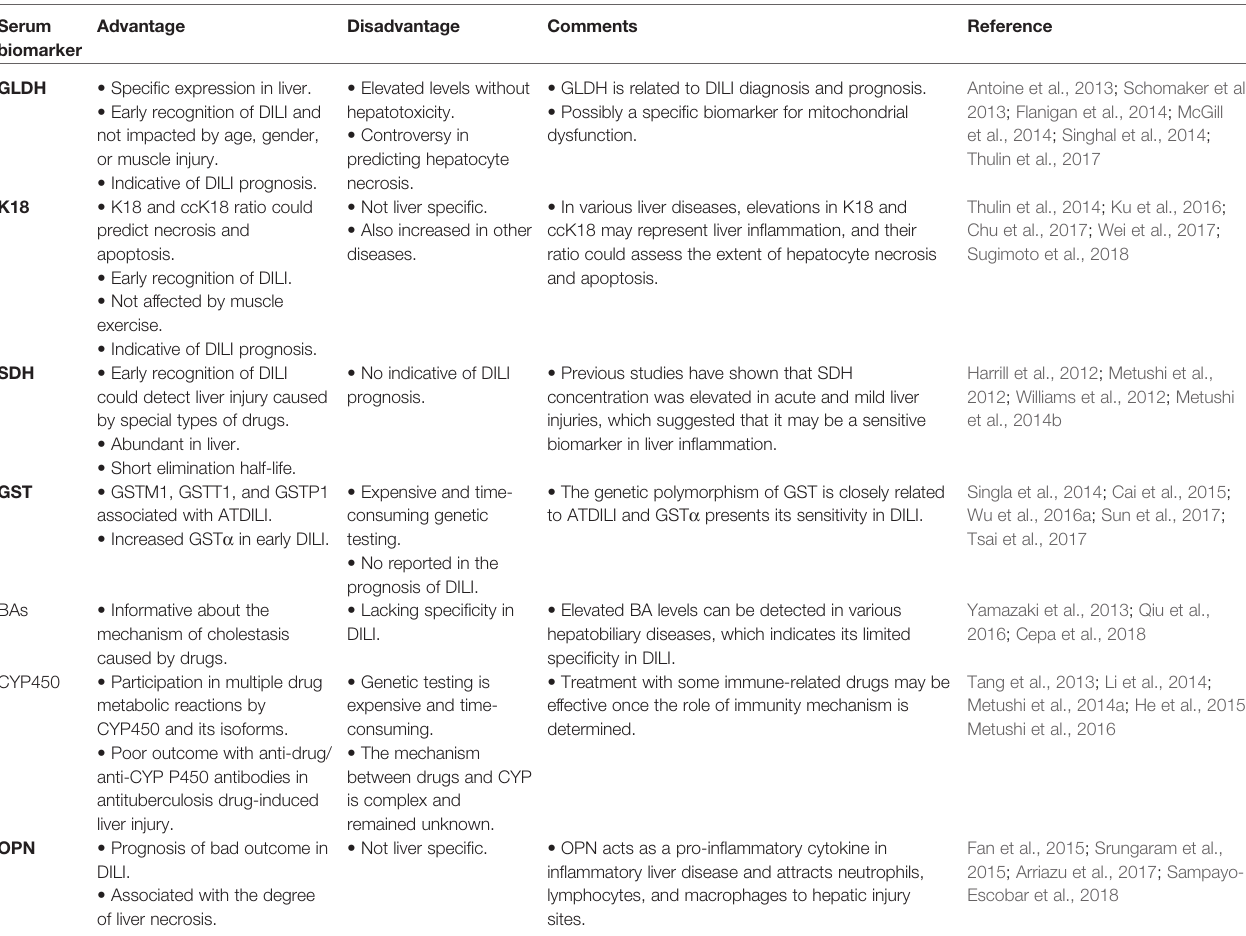
TABLE 2 | Serum Biomarkers of DILI. Serum biomarker